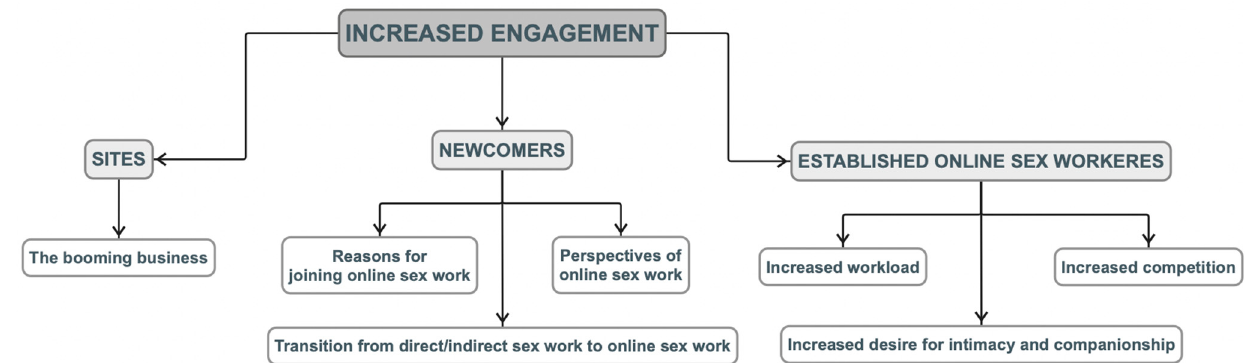
Figure 2. Diagram of core category ‘increased engagement’, sub-categories, and properties.